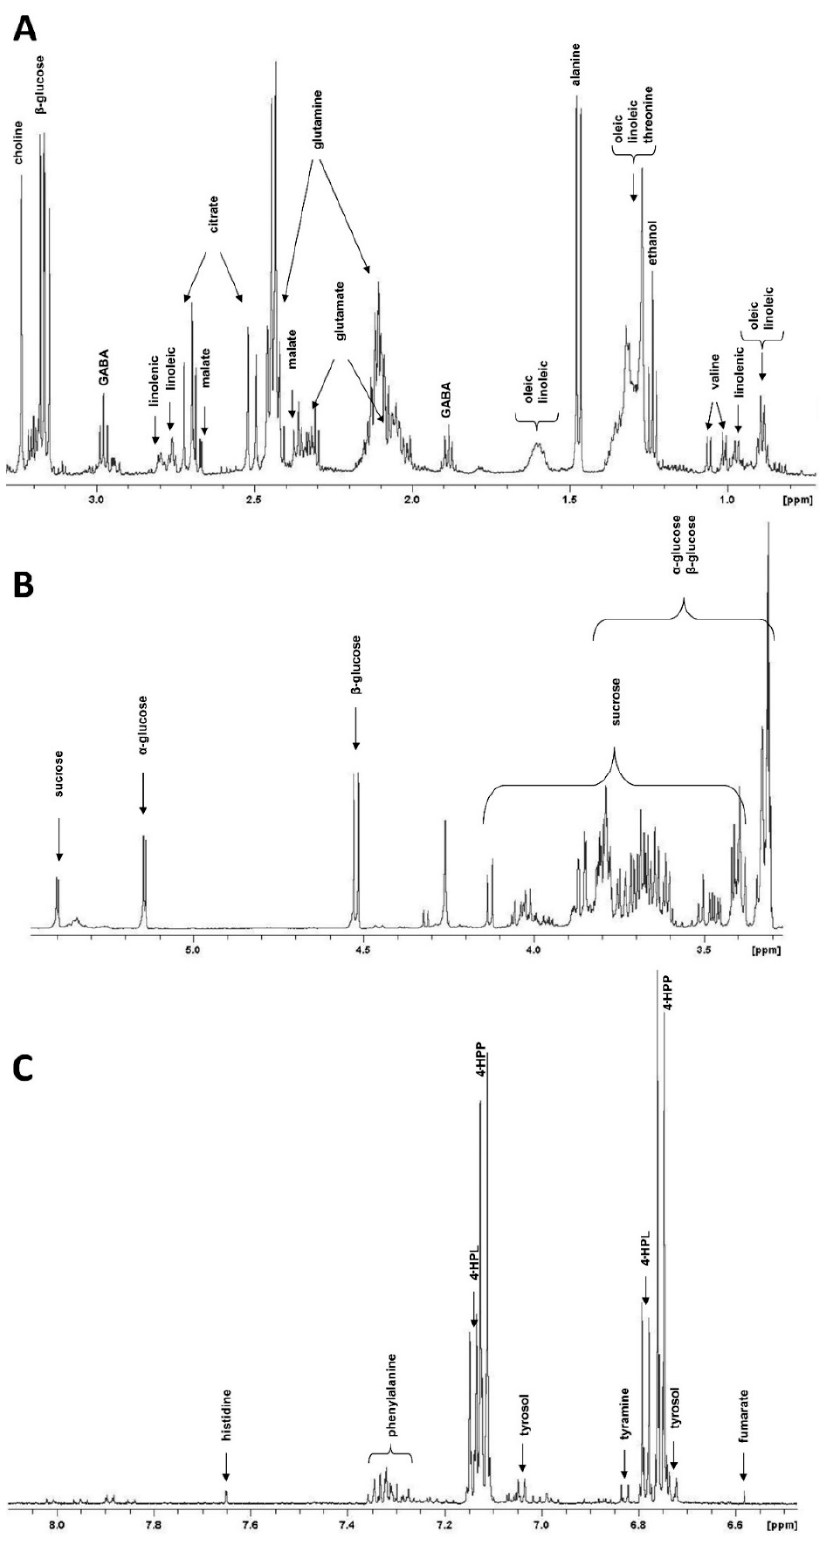
Figure3. Aliphatic( A ),anomeric( B ),andaromatic( C )regionsof 1 H-NMRspectraofthemethanol / water Figure 3. Aliphatic ( A ), anomeric ( B ), and aromatic ( C ) regions of 1 H-NMR spectra of the extracts from hemp cell suspension culture control samples. The resonance assignments of the methanol/water extracts from hemp cell suspension culture control samples. The resonance main compounds are reported. GABA: γ -aminobutyric acid; 4-HPP: 4-hydroxyphenylpyruvate; assignments of the main compounds are reported. GABA: γ -aminobutyric acid; 4-HPP: 4- 4-HPL: hydroxyphenylpyruvate; 4-HPL: 4-hydroxyphenyllactate.